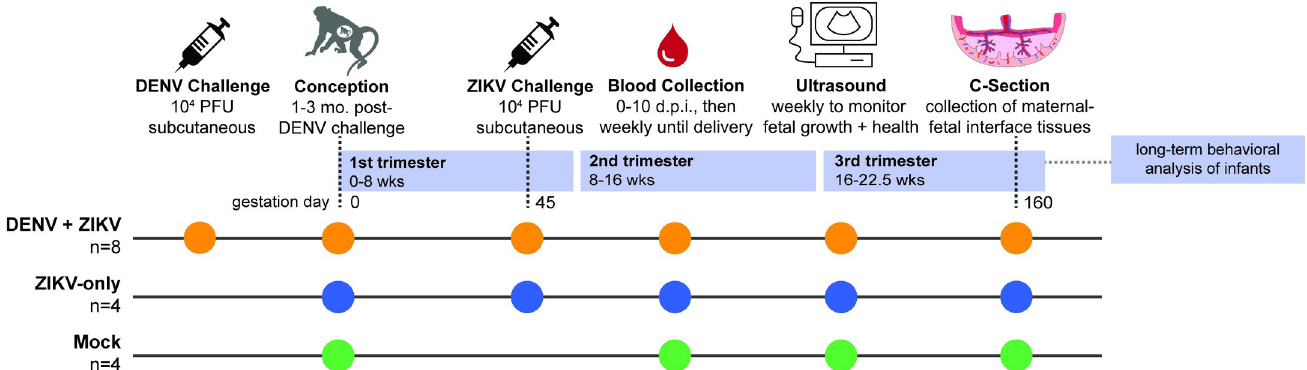
Fig 1. Experimental Overview. A cohort of eight non-pregnant macaques were challenged with 10 4 PFU DENV-2 (orange). Approximately 1–3 months following DENV challenge, the eight DENV exposed macaques were bred, became pregnant, and were challenged with 10 4 PFU ZIKV-PRVABC59, an Asian-lineage ZIKV isolate, on gestational day 45. A cohort of four pregnant, DENV-na ï ve macaques (blue) were challenged with ZIKV-PRVABC59 on gestational day 45. A control cohort of four macaques (green) were mock-challenged with PBS on gestational day 45. All three cohorts underwent the same experimental protocols for blood collection and sedation for ultrasound. At approximately gestational day 160, infants were delivered via cesarean section, and a set of maternal-fetal interface tissues with maternal biopsies were collected. Infants were placed with their mothers for long-term behavioral analysis, data from which is part of a separate study.